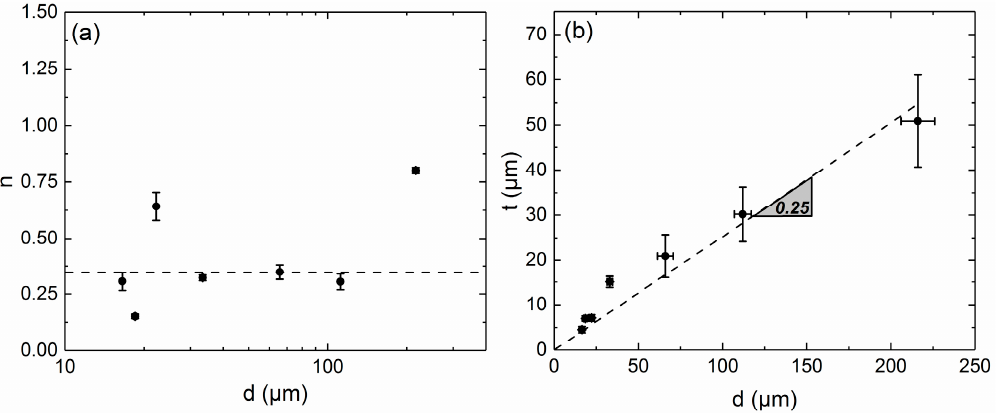
Figure 3. ( a ) Number ( n ) of annealing twin boundaries per grain and ( b ) average twin thickness ( t ) as a function of the average grain size ( d